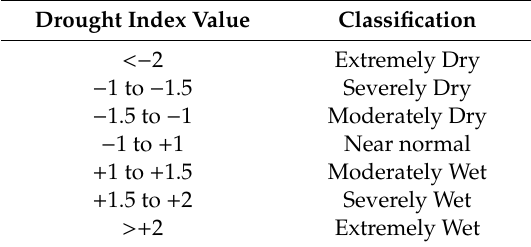
Table 4. Drought classification, following